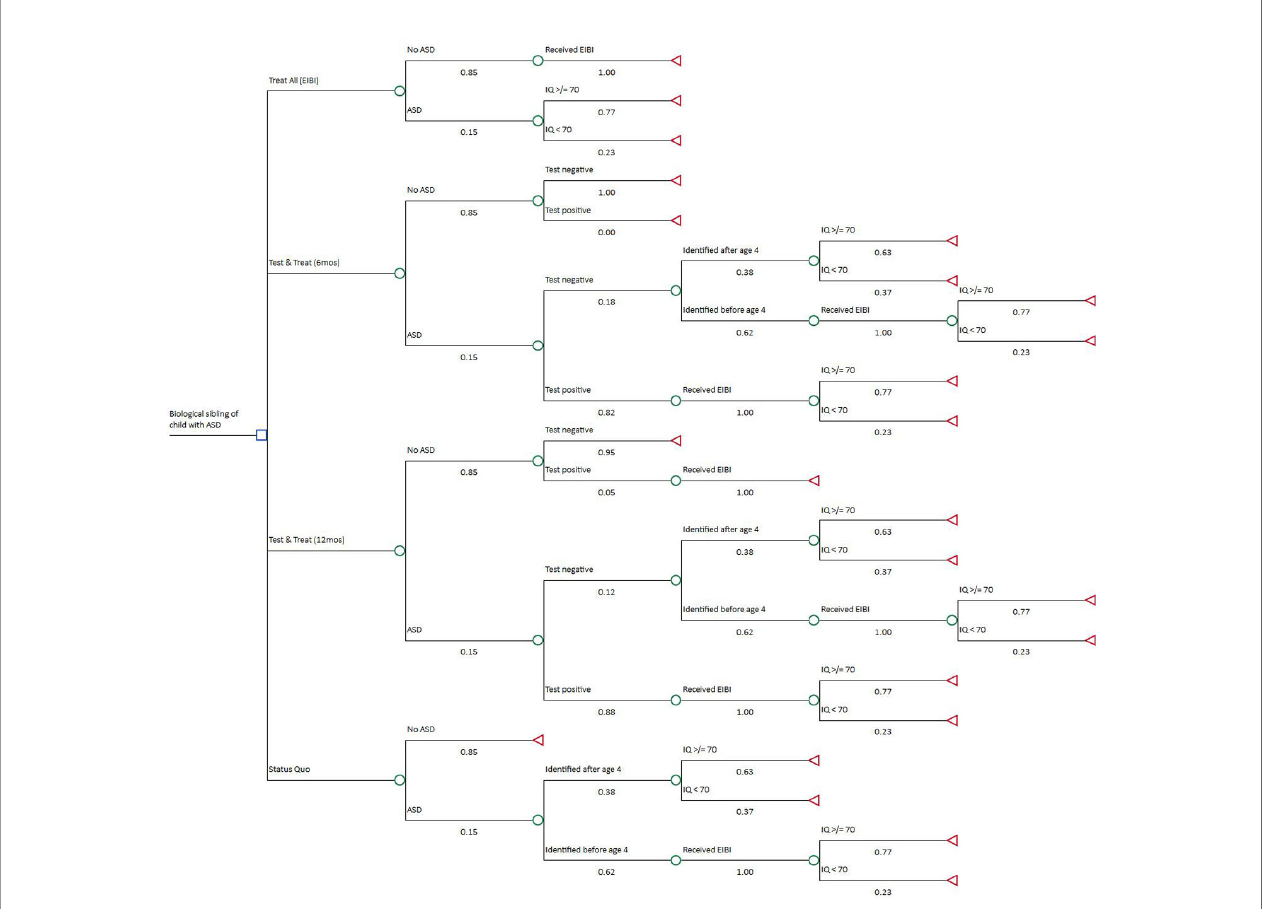
FIGURE 1 | Decision Tree. The decision node includes four strategies from top to bottom: Treat All, Test & Treat – 6 months, Test & Treat – 12 months, and Status Quo. Expected lifetime costs and quality-adjusted life years (QALYs) were calculated at each terminal node using a two-state live or die Markov